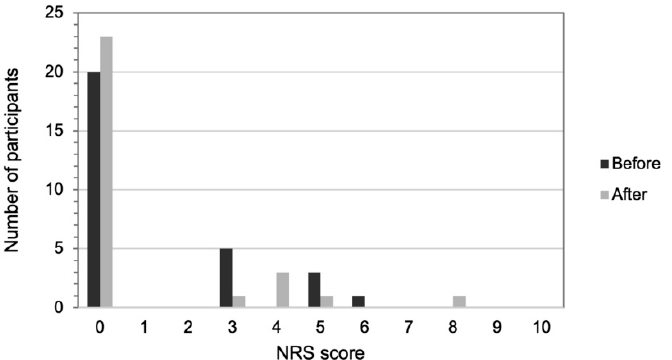
Figure 4. The distribution of numeric rating scale (NRS) scores for lower back pain before (black bars) and after (gray bars) the Nordic walking training program.